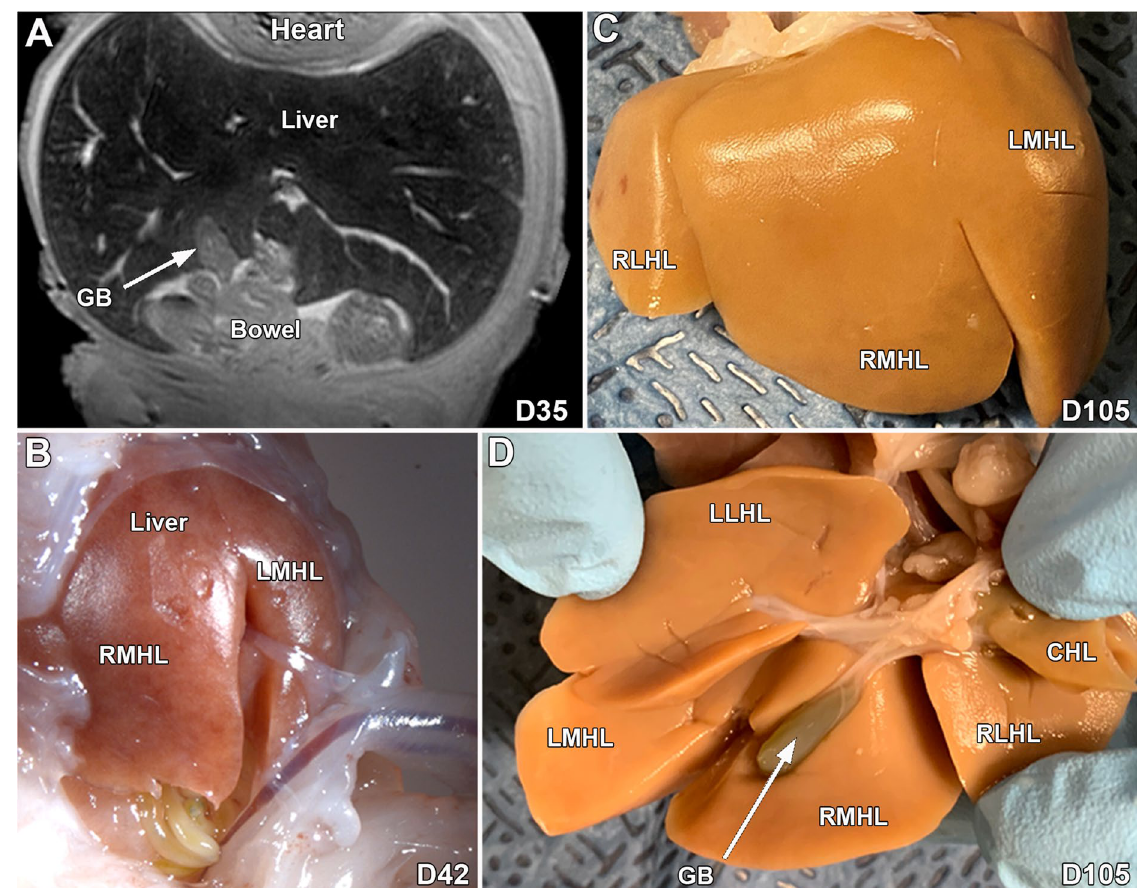
hepatic lobe, LLHL-Left lateral hepatic